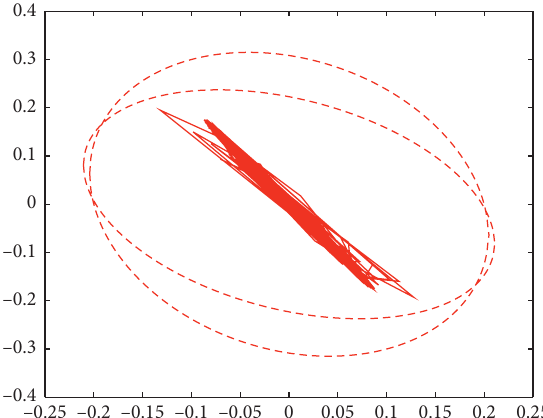
Figure 5: The ellipsoidal bound I and state trajectory of system(72) for Case 1.